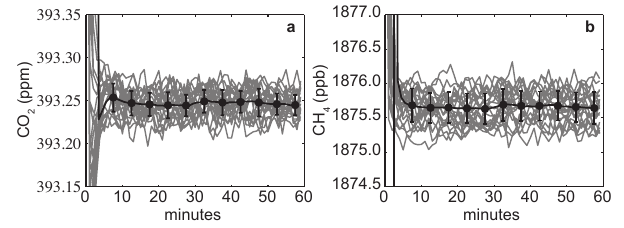
Fig. 4. Stabilization times for CO 2 and CH 4 of dry reference tanks after switching from moist ambient air. These data were collected during the month of January 2013 using the Earth Networks station at SIO with a sample module Nafion dryer inlet. Grey lines are the 1min averages of the first reference tank switched to after ambient air during the daily reference tank checks for (a) CO 2 and (b) CH 4 . This tank was sampled for 1h. The 5min ensemble averages over every daily tank run are shown in black, plotted at the mid-point, along with 1-standard deviation error